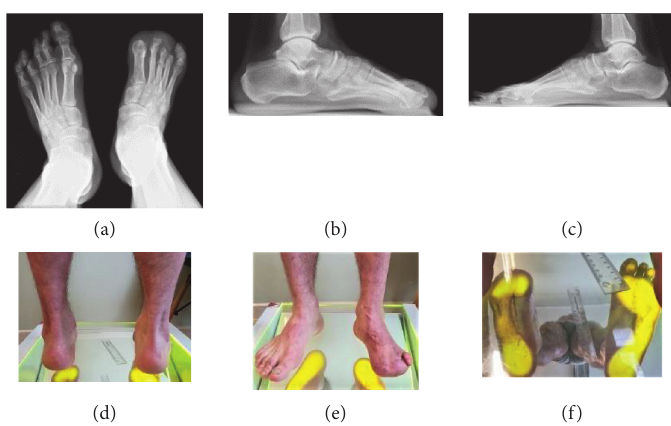
Figure 9: a–f) Results of imaging tests (X-ray) and podoscopic tests: patient no. 11. (a) Dorsal-plantar foot X-ray: fatigue fracture of the III metatarsal bone, amputation of toes I–IV in the left foot. (b) Lateral X-ray: amputation of toes I–IV, overload in the area of ankle joints, and talonavicular. (c) Lateral X-ray: overload in the area of ankle joints and talonavicular. (d) Posterior photo: ankle joint and hindfoot evaluation. (e) Anterior picture of the feet: assessment of toe positioning and deformation. (f) Plantar photo on the podoscope: assessment of plantar part of the foot and height measurement of the longitudinal arch.